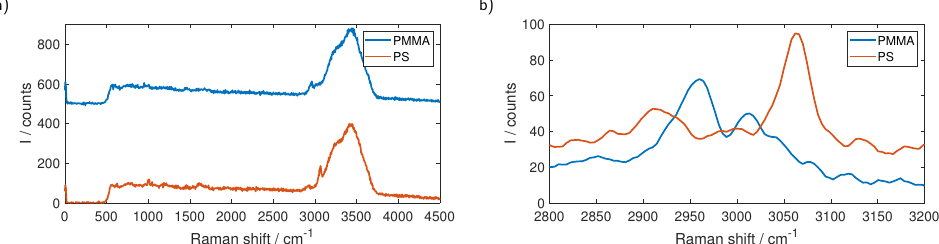
Figure 7. ( a ) Measurement of a sample containing PS as well as PMMA. For better visibility, the measurements are stacked by adding an offset. Although both plastics have their relevant lines in the area of the water response, they are already distinguishable in the raw data. ( b ) The same measurement after subtracting the background and smoothing the data with a Savitzky–Golay filter without the offset. The spectra are easily